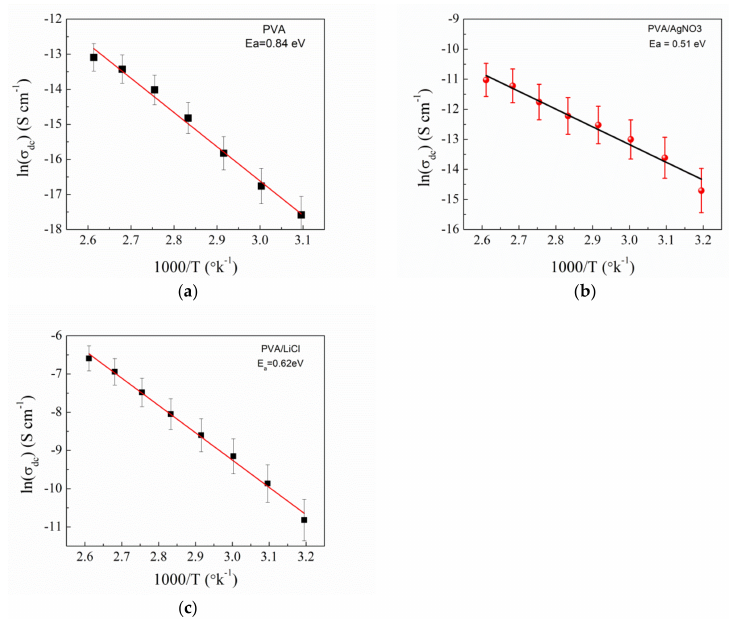
Figure 6. The ln( σ dc ) vs. 1000/ T for PVA ( a ), PVA/LiCl film ( b ) and PVA/AgNO 3 ( c ) films.